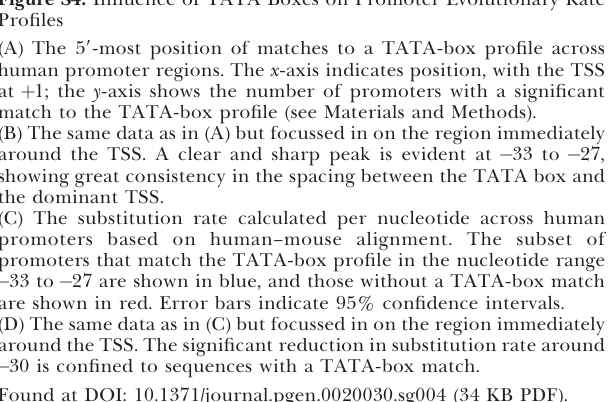
Table S3. Significantly Over-Represented GO Annotation Terms within Mouse Genes Possessing Rapidly Evolving Promoters with C , 0 GO biological process ID numbers and descriptions are given together with the number of genes under scrutiny possessing the GO term (n), the total number of mouse genes annotated with the GO term ( ‘‘ total ’’ ), and the corrected p -value calculated for the enrich- ment of the GO term. Table S4. Significantly Over-Represented GO Annotation Terms within Human Genes Possessing Rapidly Evolving Promoters with C , 0 GO biological process ID numbers and descriptions are given together with the number of genes under scrutiny possessing the GO term (n), the total number of human genes annotated with the GO term ( ‘‘ total ’’ ), and the corrected p -value calculated for the enrich- ment of the GO